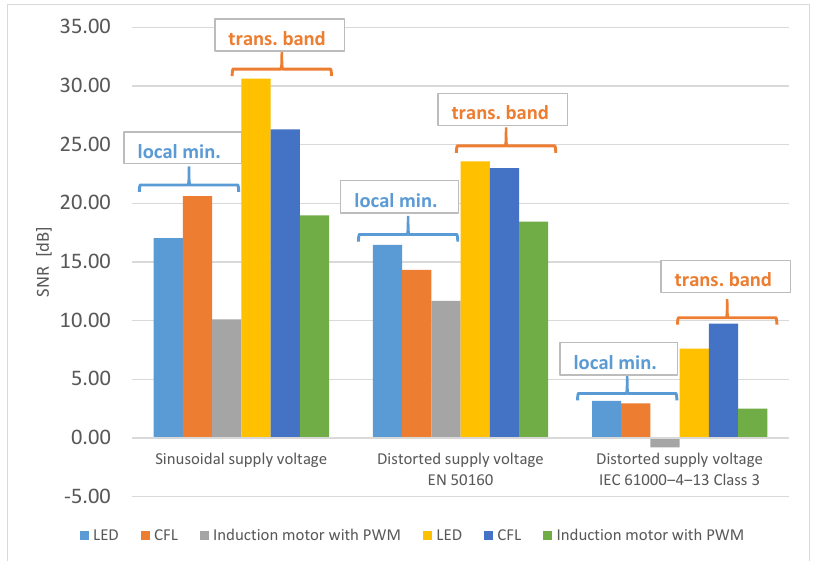
Figure 12. Impact of the supply voltage distortion grade on the signal to noise ratio (SNR) in the transmission band 42–89 kHz of the investigated PRIME PLC system. Table 5. The statistics of the transmission of the investigated PRIME PLC during the different sce- narios of supply voltage distortion and variant types of loads (2 h continuous work).